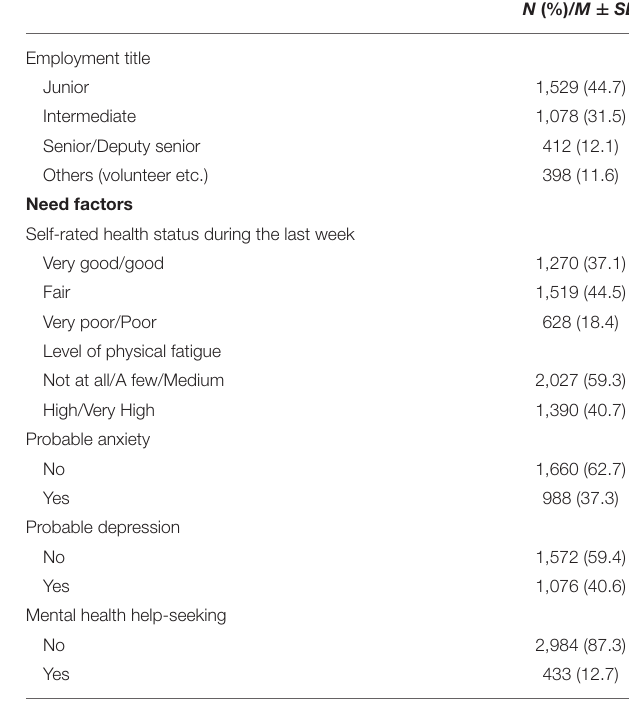
TABLE 1 | Characteristics of health care workers who perceived probable mental health problems ( N =